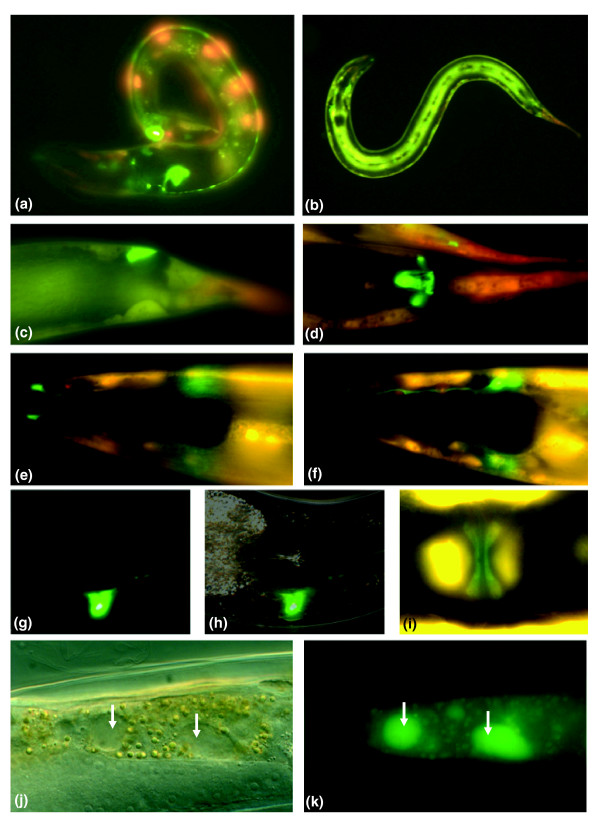
Expression domains of common response genes and symptoms associated with infection. pF44A2.3::GFP expression in the (a) ventral nerve-cord, (b) hypodermis, (c-d) P12.pa pre-anal cells, (e-f) glial amphid socket cells, (g-h) excretory duct cell and (i) vulE or uv1 cells. Red fluorescence comes from the pcol-12::dsRED co-injection marker. In areas where both GFP and dsRED are expressed, yellow is observed. (j,k) Vacuoles (arrows) can be observed within intestinal cells of P. luminescens-infected adults (j), in which there is detectable expression of asp-4::GFP (k). Similar results were obtained with infected adults expressing asp-3::GFP. In contrast, no GFP expression or vacuolization was seen in the intestines of non-infected worms.